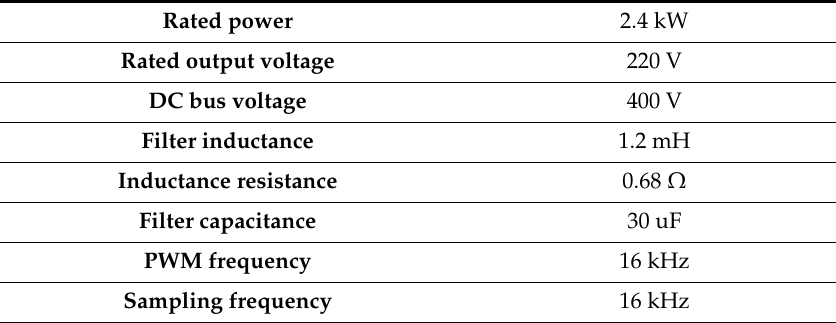
Table 1. Design parameters of the